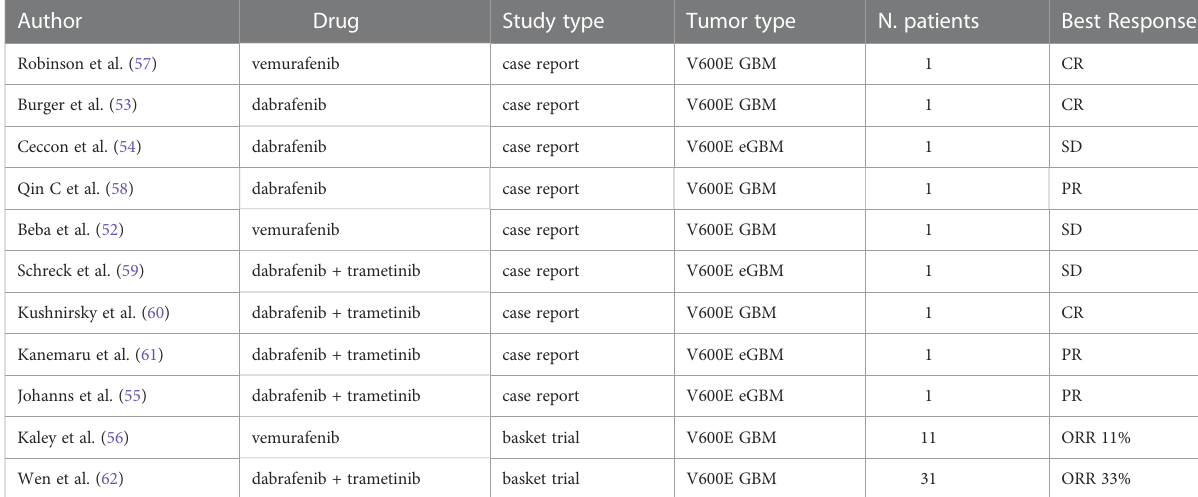
TABLE 2 Available clinical data on BRAF V600E mutated GBM and eGBM treated with BRAF inhibitors alone or in